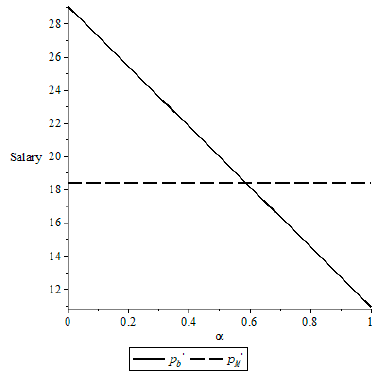
Figure 3. Change of the salary with α .